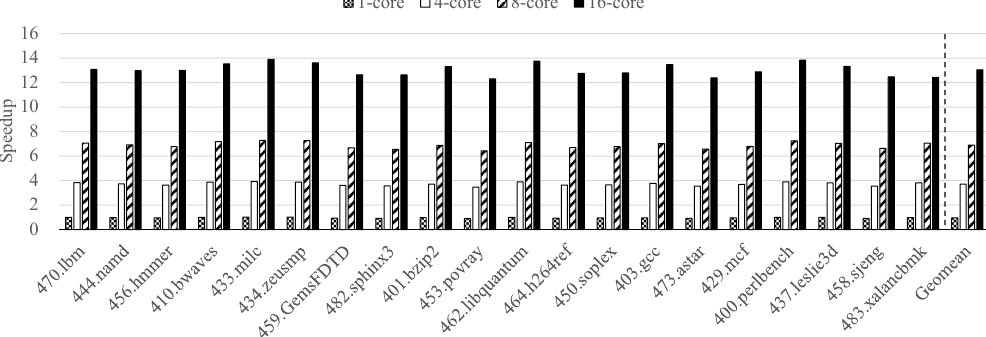
s Figure 5. The speedup achieved by EPSim using a multicore platform on the SPEC CPU2006 benchmarks